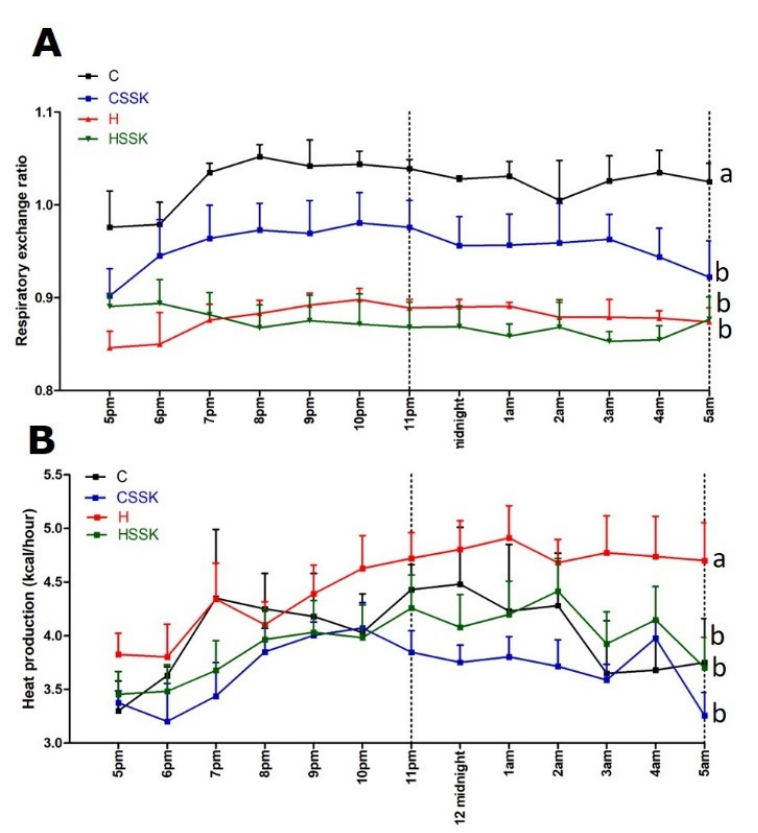
Figure 1. ( A ) Twelve-hour indirect calorimeter data for respiratory exchange ratio and ( B ) heat production. End-point means with unlike superscripts differ (a or b), P < 0.05. C: corn starch diet-fed rats; CSSK: corn starch diet-fed rats supplemented with Saskatoon berry powder; H: high-carbohydrate, high-fat diet-fed rats; HSSK: high-carbohydrate, high-fat diet-fed rats supplemented with Saskatoon berry powder.